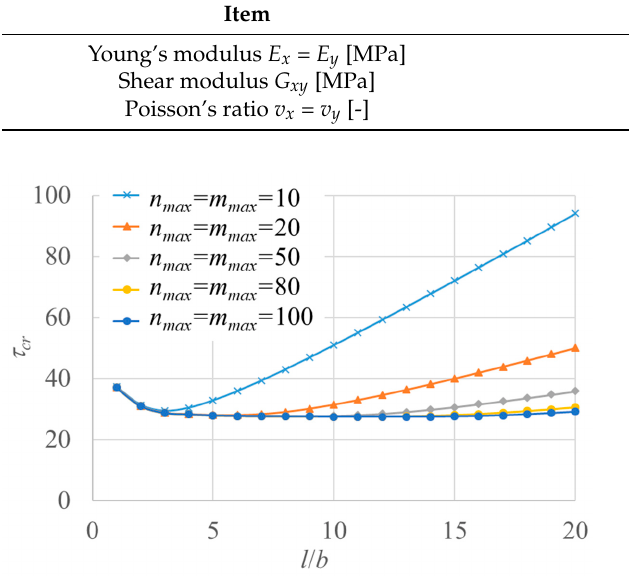
Figure 4. Convergence of buckling load for terms of m and n .